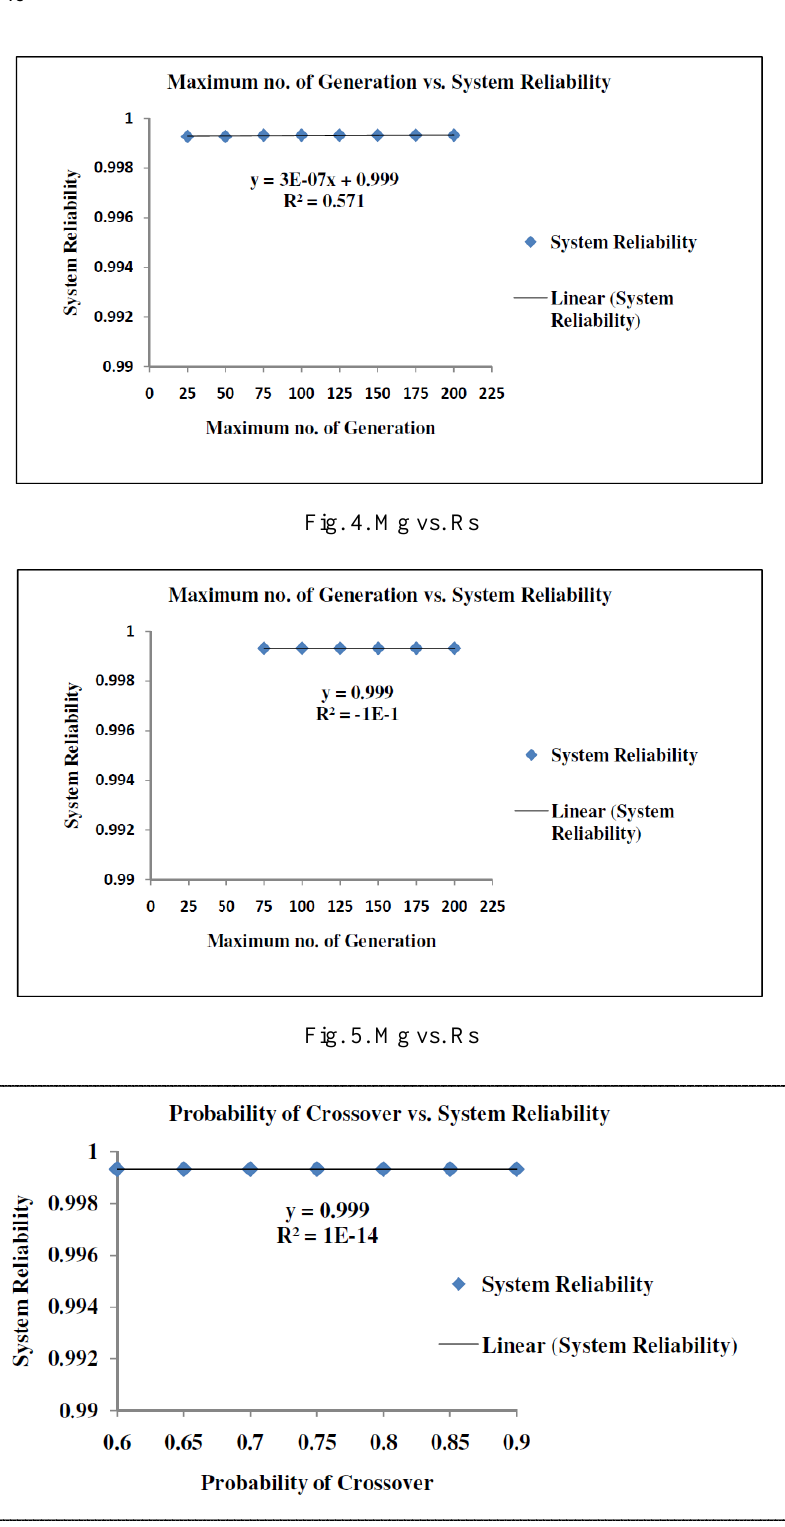
Fig. 6. Pc vs. 269